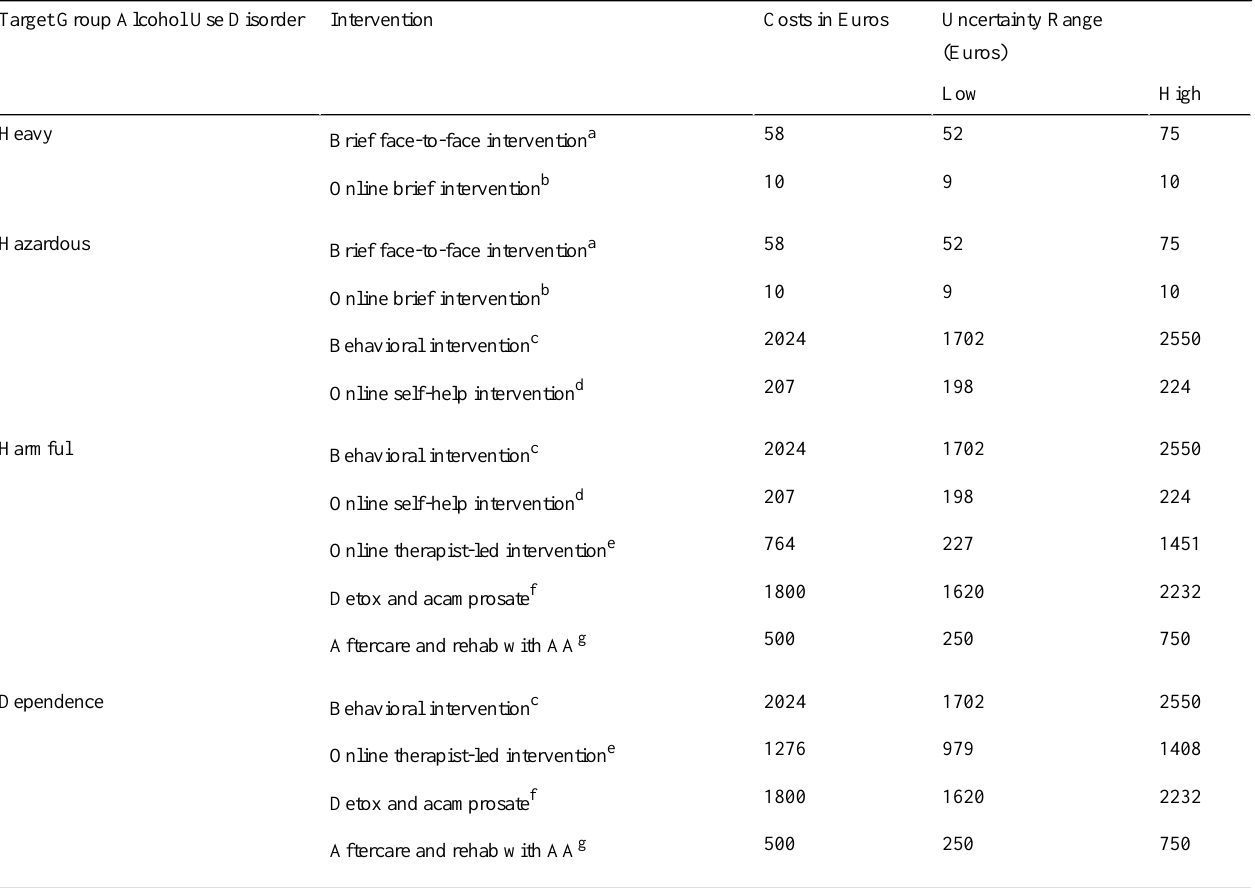
Table 2. Per-patient intervention costs in 2009 euros (€) within uncertainty range (based on 1000